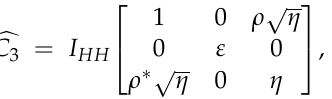
Figure 4. ( a ) The ground object type map. ( b ) PauliRGB image of the 1st PolSAR image. ( c ) The original coherence map. ( d ) The simulated deformation phase of the first interferogram.